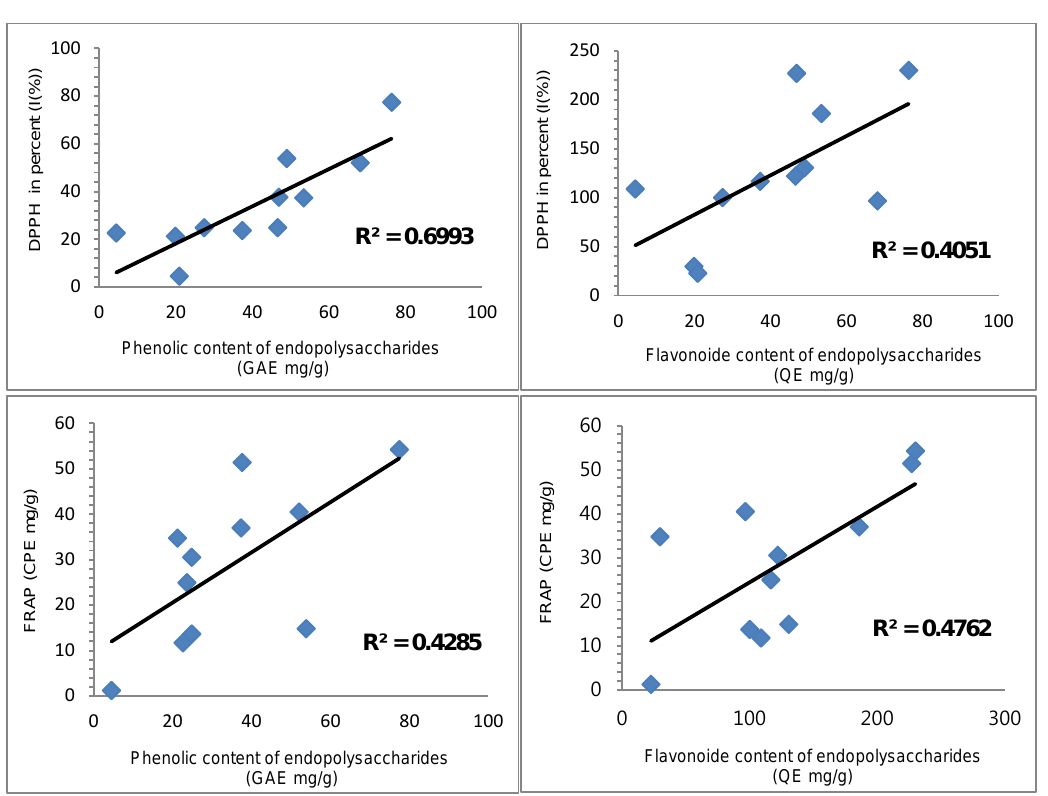
Figure 4. Correlation R 2 values of antioxidant activities between phenolic and flavonoid contents (endopolysaccharides).